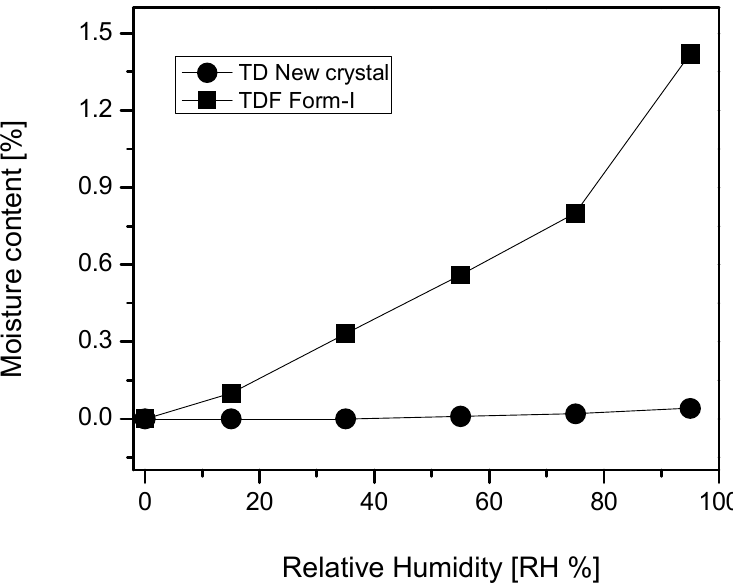
Figure 6. Hygroscopicity evaluation of the new TD free base crystal and TDF Form-I in accordance with the relative humidity (RH) change.